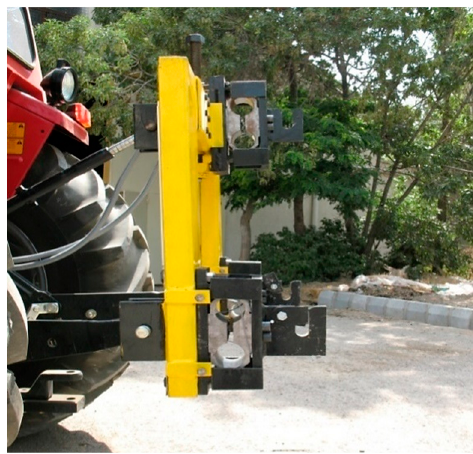
Figure 1. Adjustable three-point hitch dynamometer for measuring the draft force of implements.